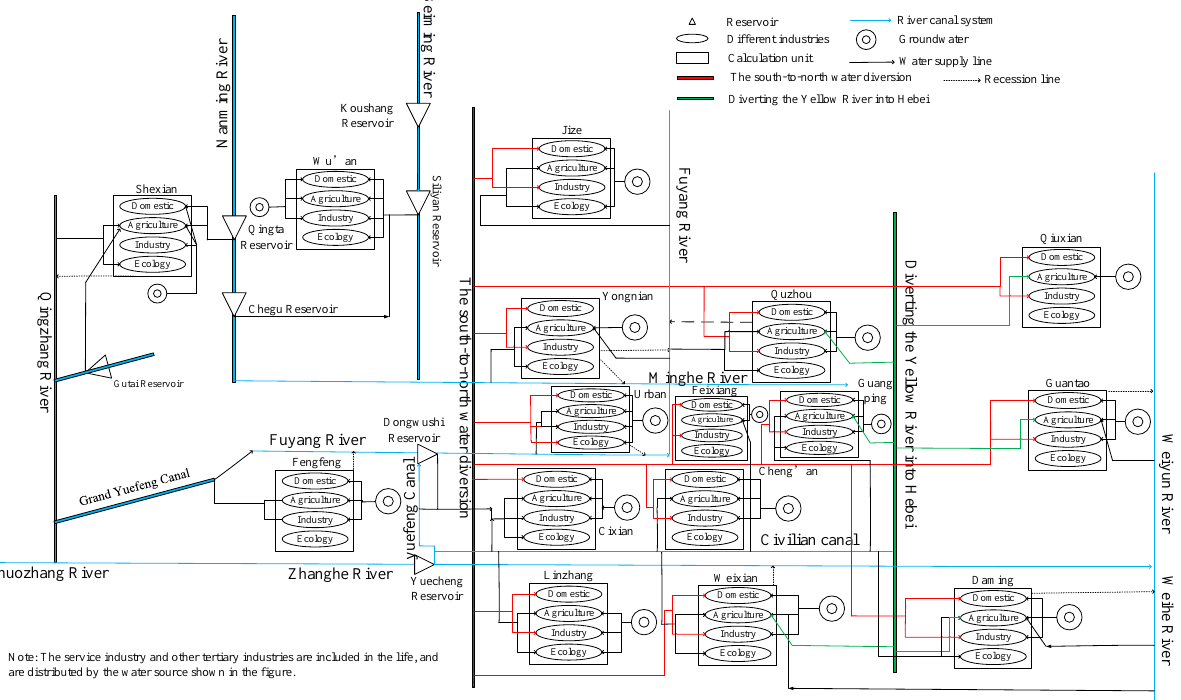
Figure 5. The network diagram of the water resource system in Handan City.